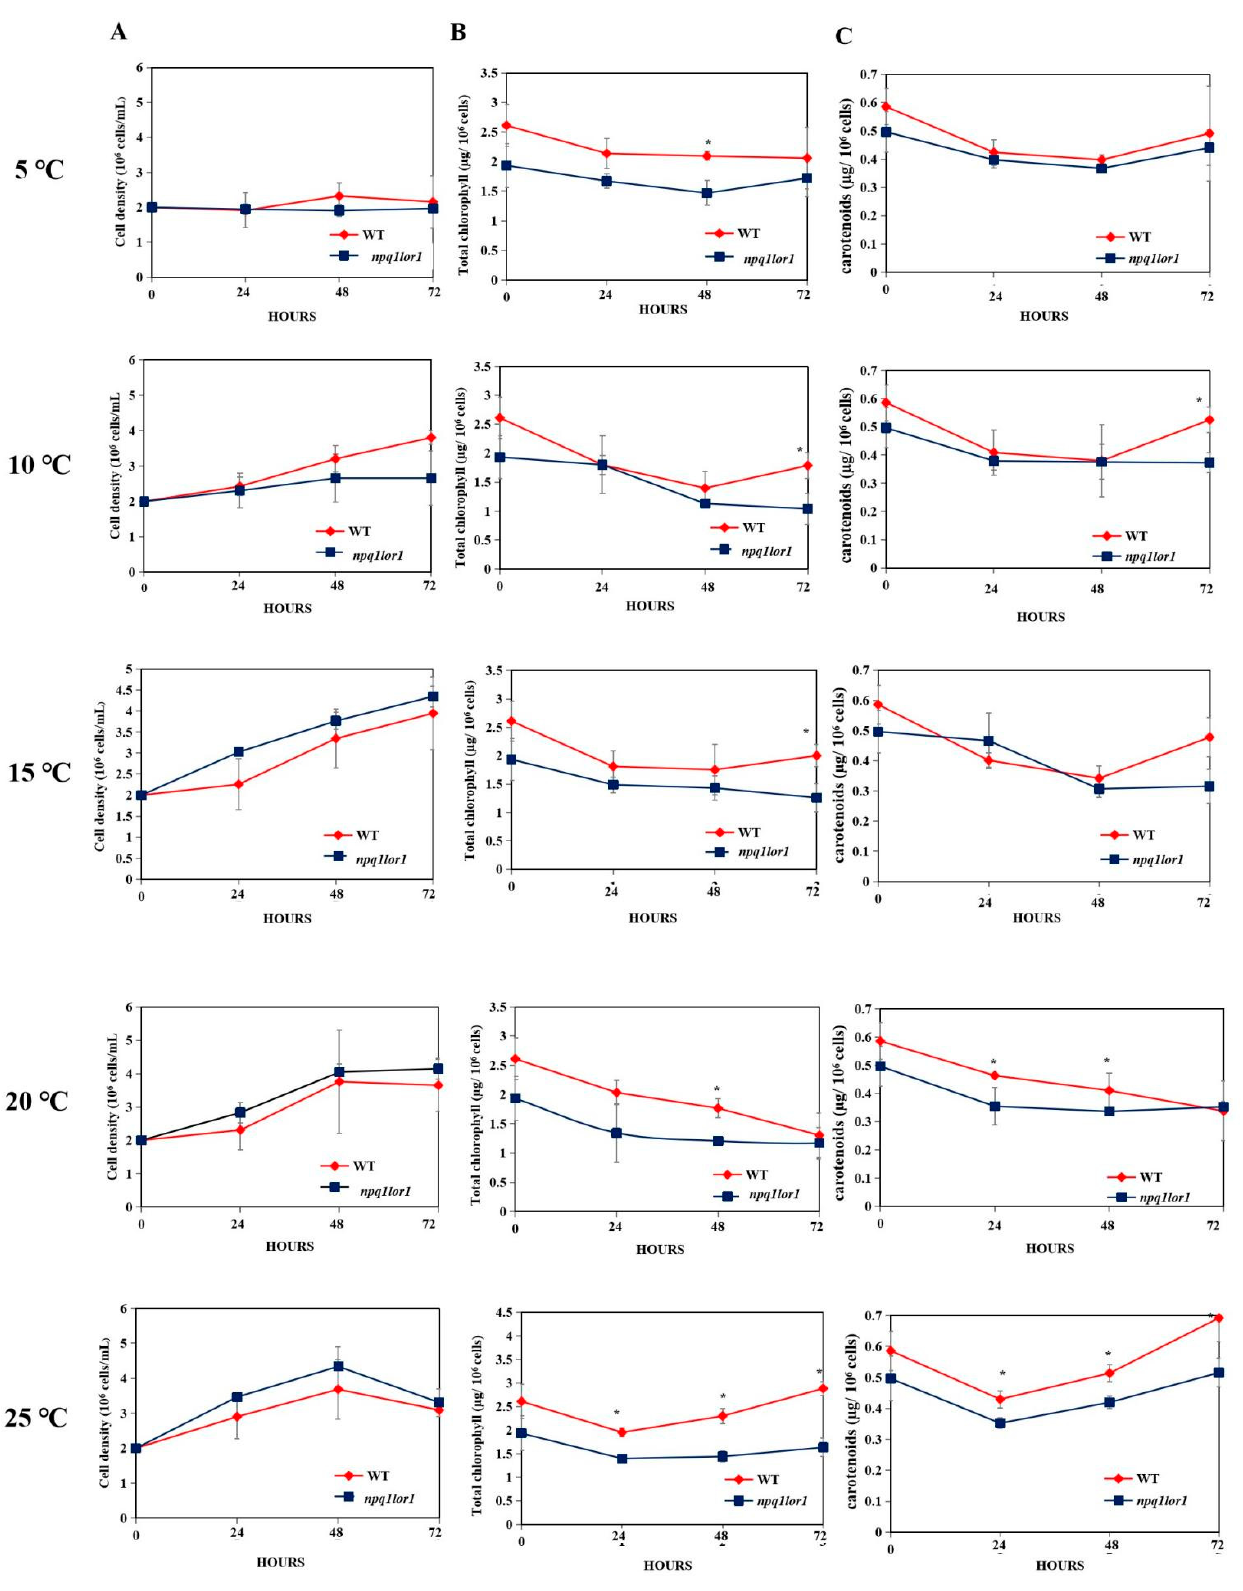
Figure 5. Growth ( A ), chlorophyll ( B ), and carotenoid ( C ) content of C. reinhardtii WT and npq1lor1 under different conditions. All data are means ± SD of three biological replicates. Significant differences between WT and npq1 lor1 mutant are indicated by asterisks (*) ( p < 0.05).